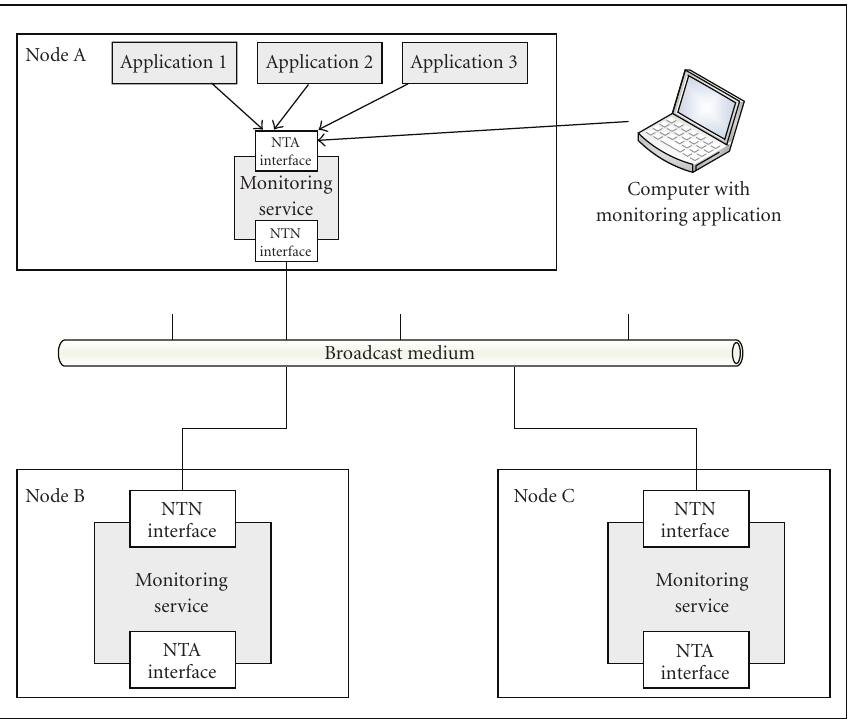
Figure 4: Communication between monitor daemons using the NTN interface and with applications using the NTA